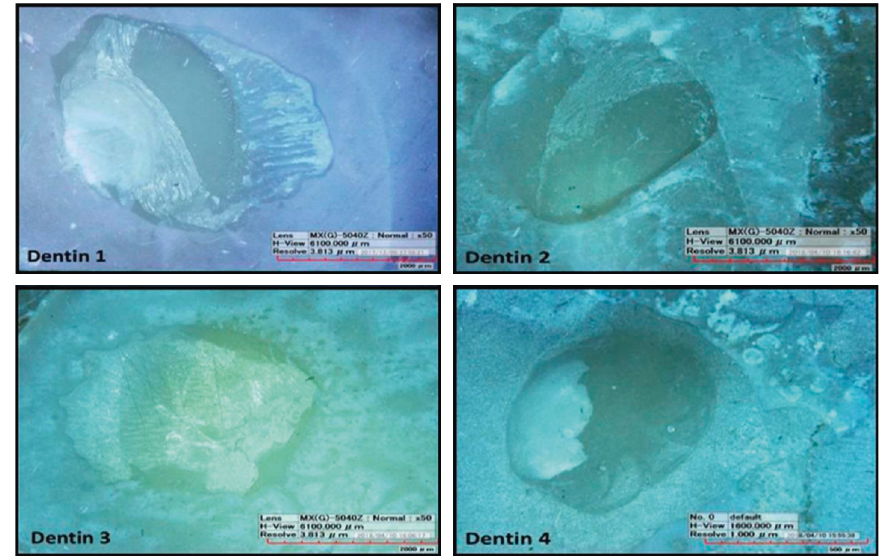
Figure 5: Digital microscopy images of bonded dentin specimens after the shear bond strength